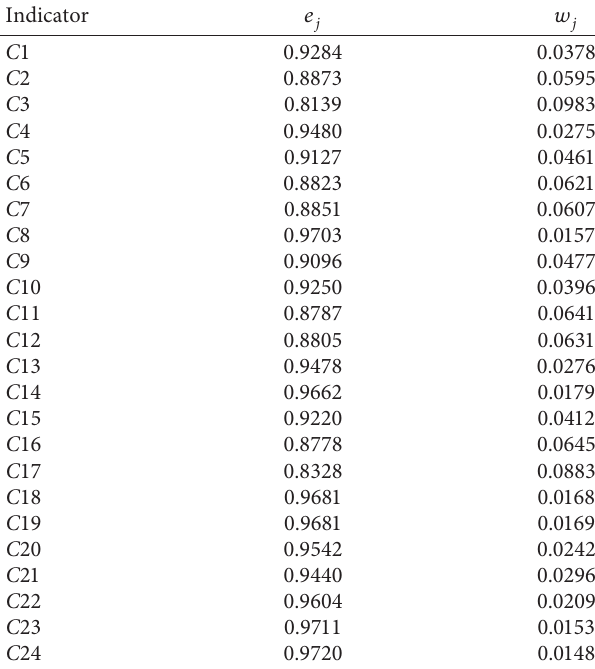
Table 2: The weight of each indicator.